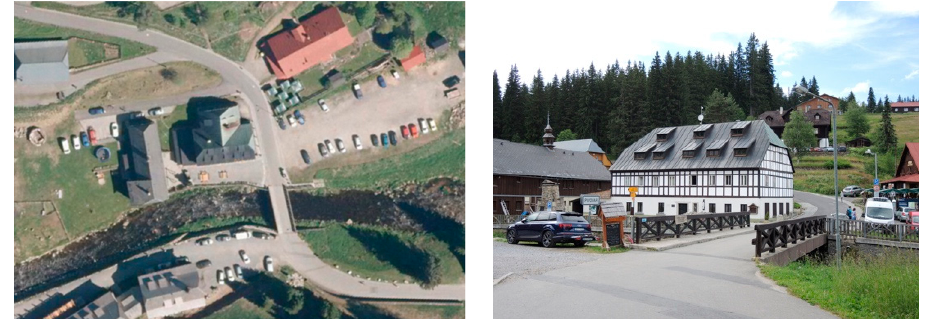
Figure A9. Aerial photo and photo of class F.